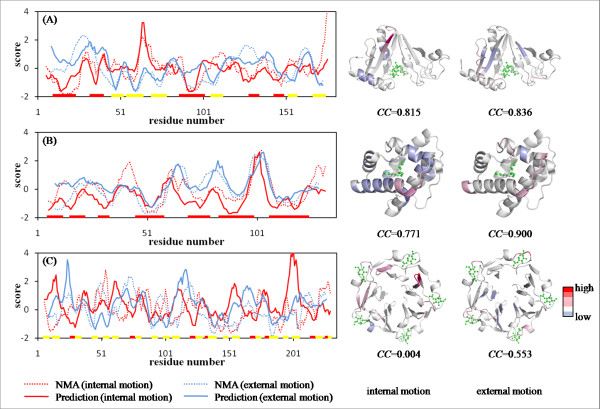
Examples of prediction results. Prediction results of (A) aminoglycoside 6'-N-acetyltransferase (PDB code: 1B87), (B) pheromone-binding protein (PDB code: 1DQE), and (C) tachylectin-2 (PDB code: 1TL2) are shown in the graph on the left side. The red and blue lines show predicted scores for internal and external motion; red and blue dotted lines respectively signify calculated scores obtained using NMA. The residue number is shown on the horizontal axis. The locations of secondary structures are shown as red and yellow bars, respectively, for α-helix and β-sheet. The scores of the two motions are presented on the vertical axis. On the right side, the predicted scores for internal and external motions are mapped, respectively, with a gradient from negative (blue) to positive (red) onto their structures of the left and the right sides. Green signifies a ligand. A correlation coefficient between predicted scores and normalized NMA scores is shown as CC. These results were obtained using the method that implemented psipred and sable.